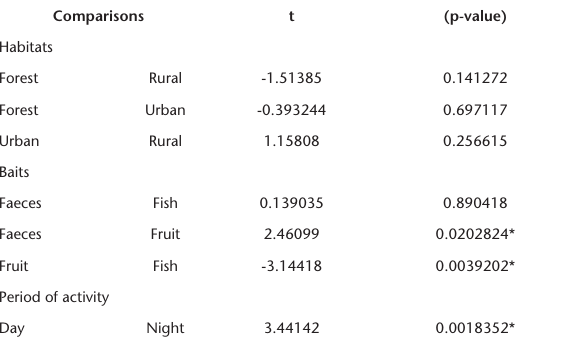
Table 3. Comparison of the abundances of species through paired Student’s t -Tests between the habitats, baits and period of activity of Sarcophaginae flies in the Colombian Guajira